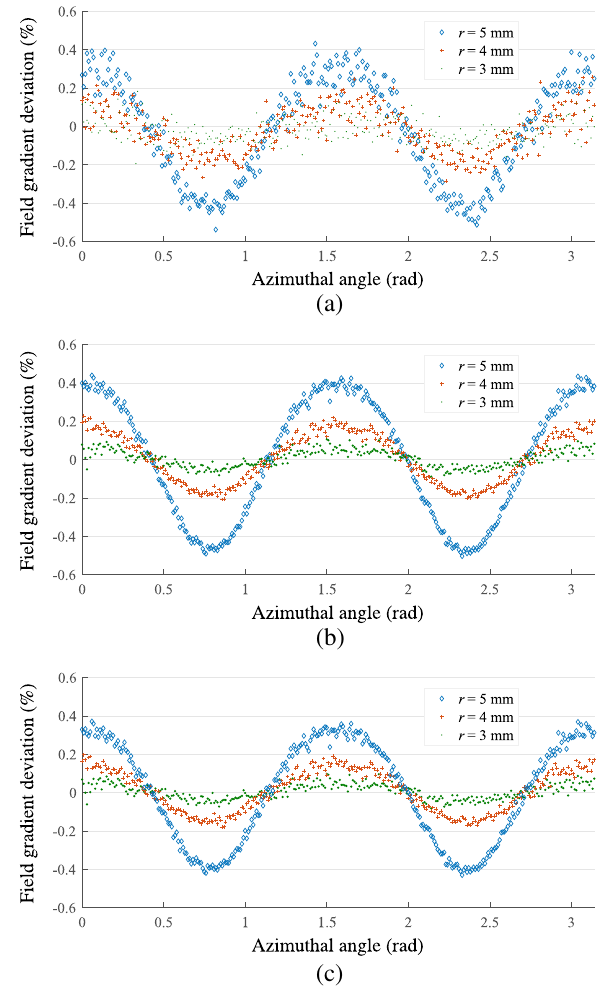
FIG. 12. Angular field gradient deviation in the hybrid design when adjusting excitation current. (a) Zero current; (b) Maximum current density J ¼ 50 A = mm 2 ; (c) Maximum opposing current density J ¼ − 50 A = mm 2